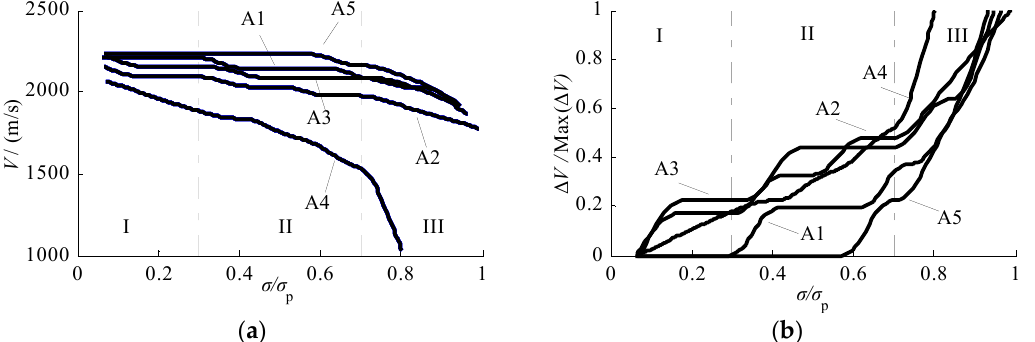
Figure 6. Change of wave velocity during the destruction of specimens with different moisture contents ( a ) wave velocity; ( b ) attenuation of wave velocity.